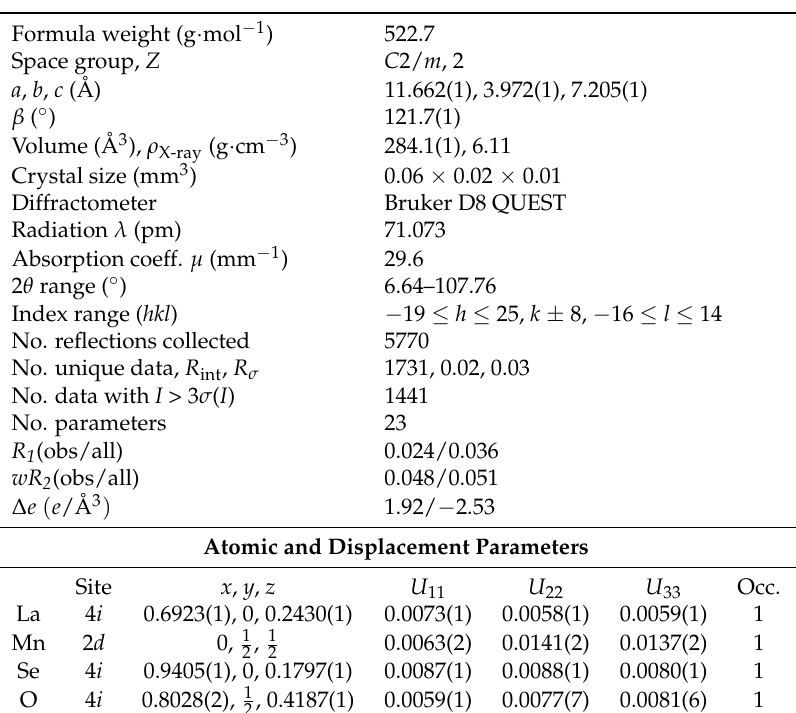
Table A1. Crystallographic data of mC -La 2 MnSe 2 O 2